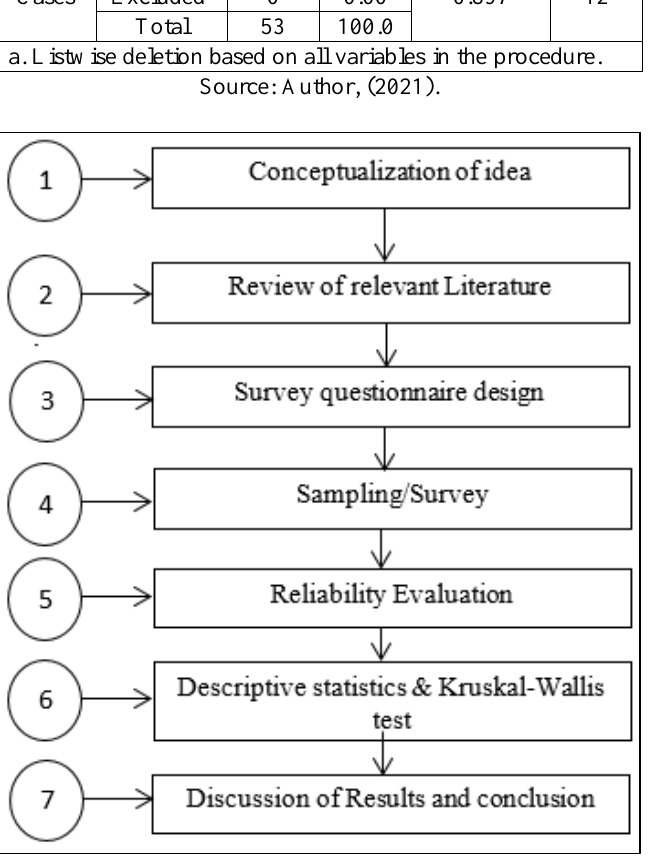
Figure 1: Methodological procedure flow chart.